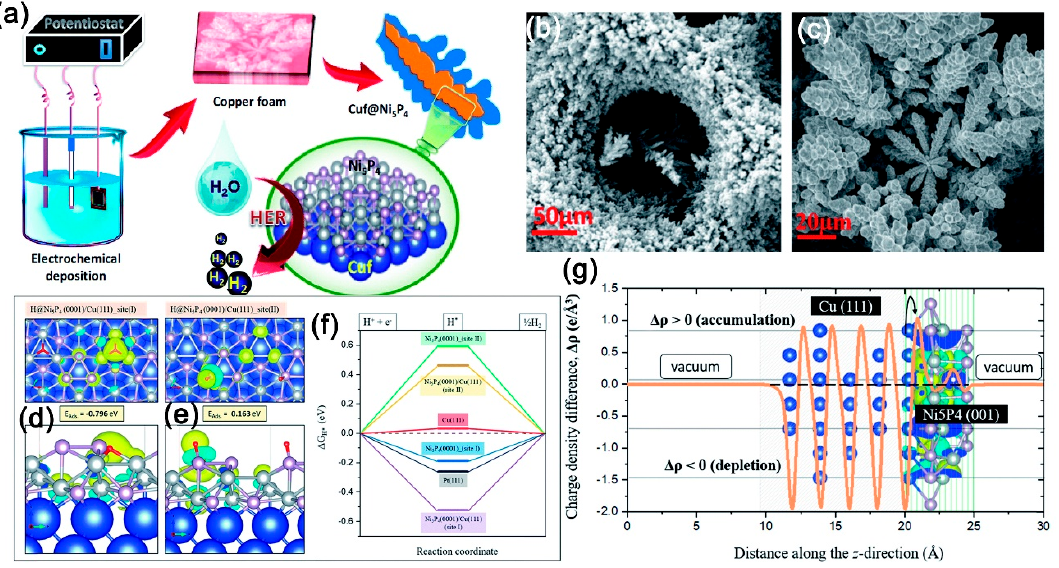
Table 9. Comparison of the preparation methods of nickel phosphide electrocatalysts for HER. Methods Advantages Disadvantages Easy to fabricate nickel phosphide Solution-phase method